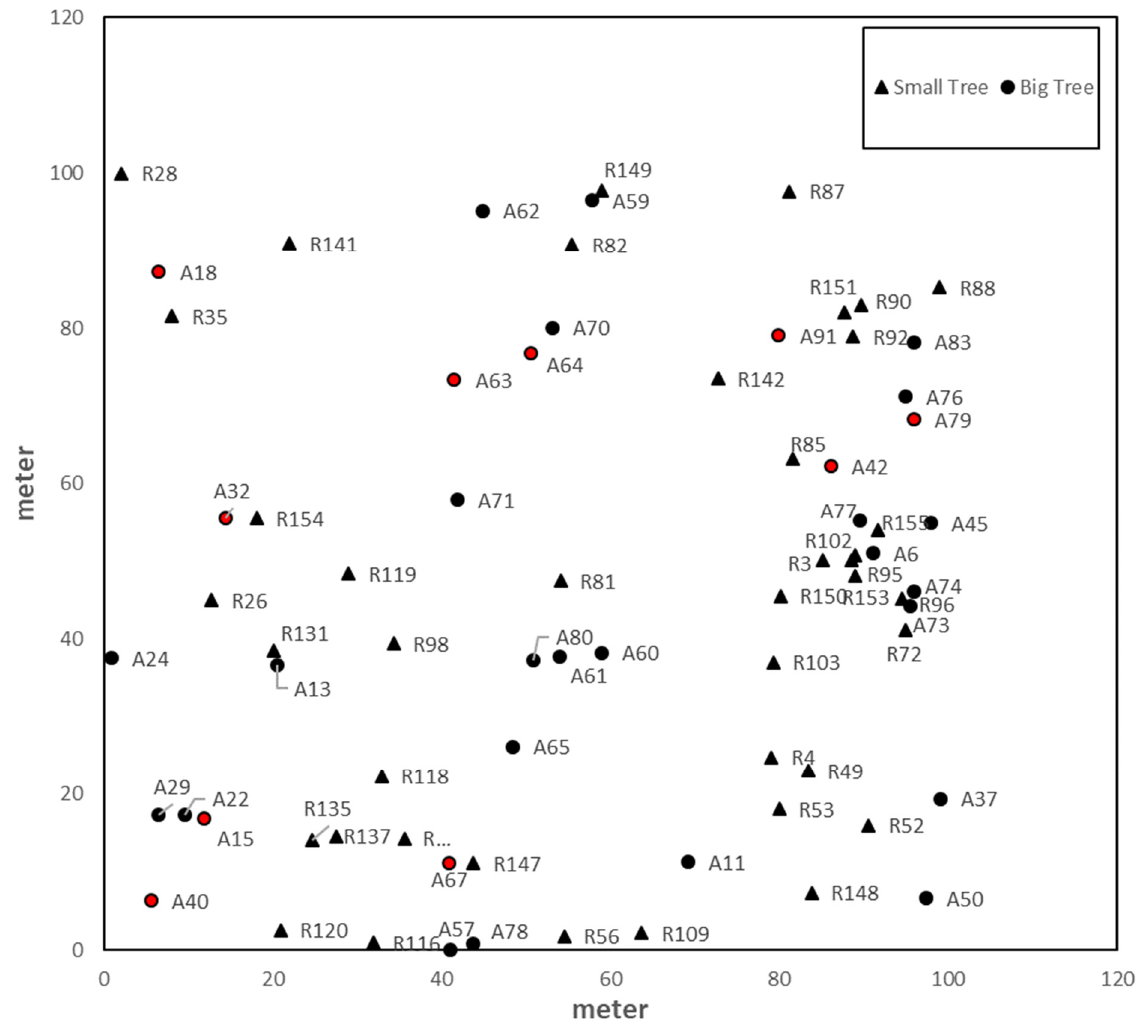
Figure 3. Distribution of 34 big (A) and 41 small (R) Shorea acuminata trees in 1 hectare compartent 107, Kenaboi FR. The potential seed trees are displayed with red circle.